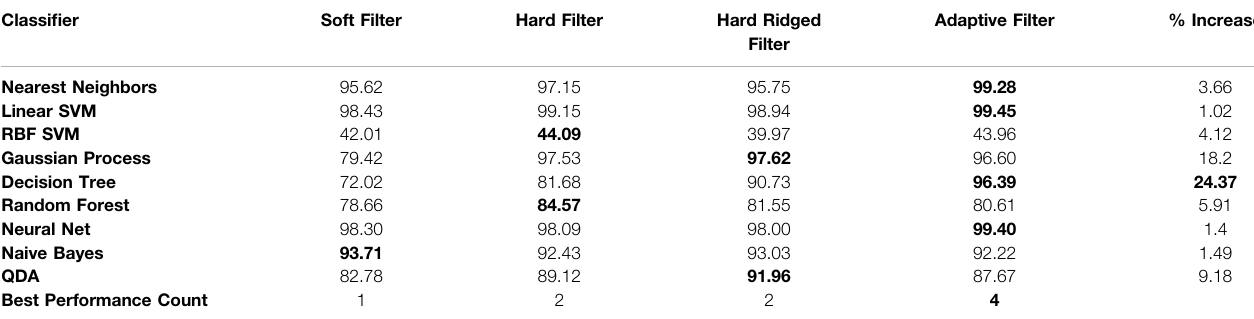
TABLE 1 | Accuracy of 9 classi fi ers to discriminate across 8 objects. Each of the accuracies reported are averaged across 50 runs. Each run corresponds to the respective classi fi er fi t on PCA projected tactile data from one up to 50 dimensions. Classi fi er Soft Filter Hard Filter